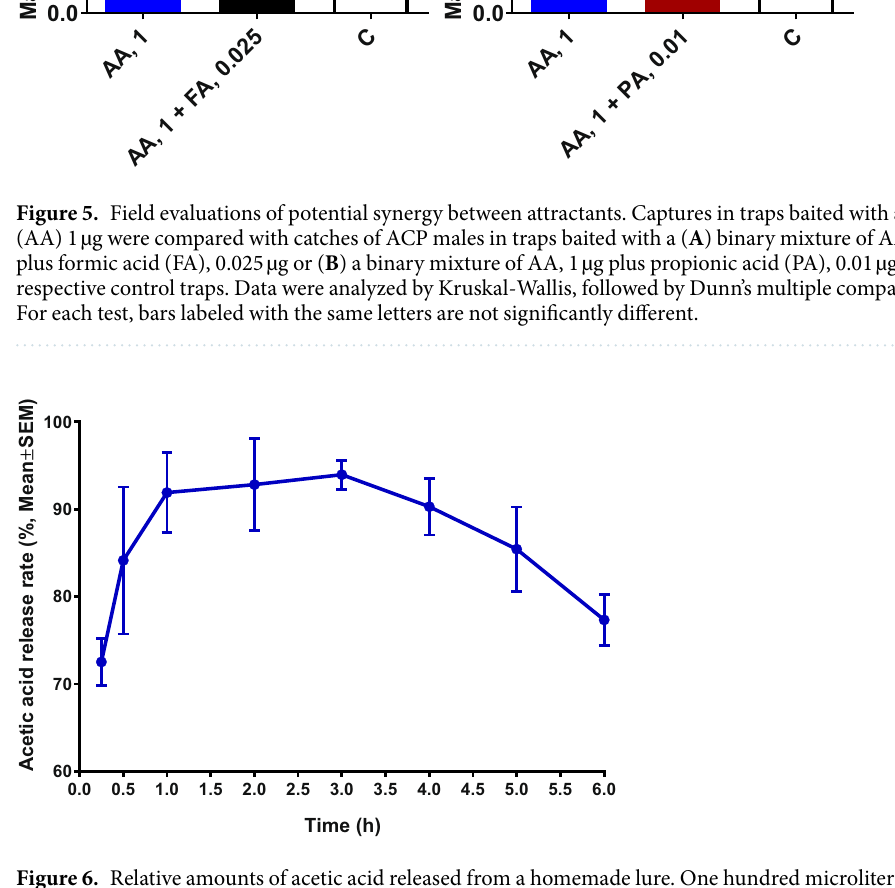
Figure 6. Relative amounts of acetic acid released from a homemade lure. One hundred microliters of a solution of acetic acid in hexane (0.01 mg/ml) were loaded on an ethylene-propylene side-by-side device. After solvent evaporation (5 min), headspace volatiles were captured for 1 min with HiSorb and analyzed by TD-GC/ MS with single-ion monitor (m/z 61). n =